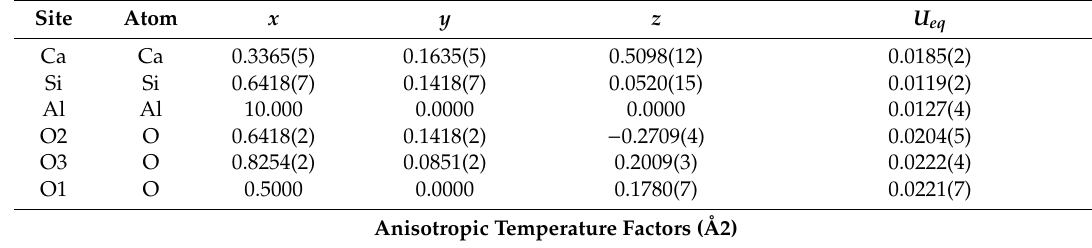
Table 3. Structure factors obtained for a selected sample of gehlenite from M ă gureaua Va¸tei (sample CE 4